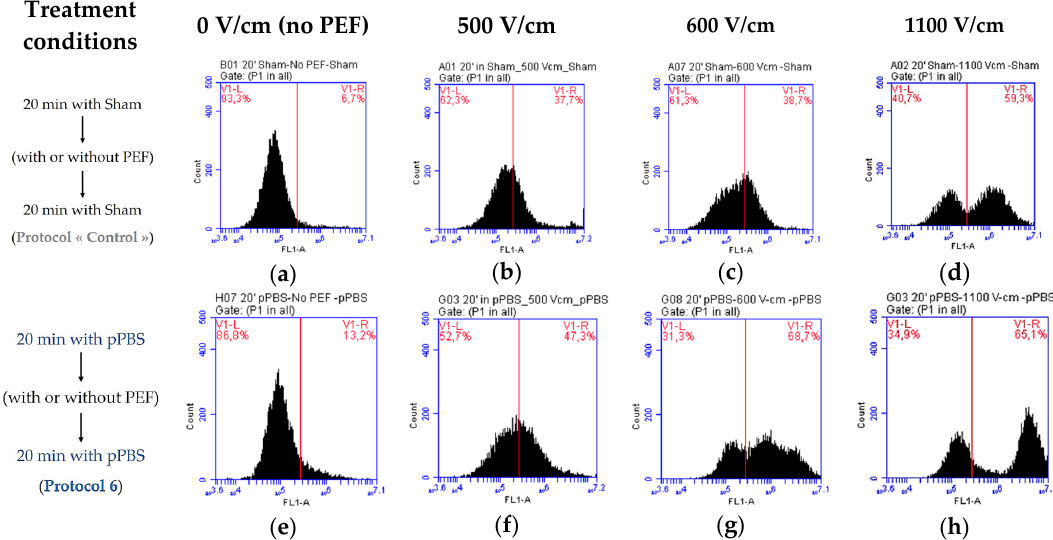
Figure 8. Flow cytometry analysis of a few interesting conditions of the combined treatment in adherent B16-F10 murine melanoma cells to compare effects of protocol 6 ( e – h ) versus the control ( a – d ) with µsPEFs of 0 ( a , e ), 500 ( b , f ), 600 ( c , g ), and 1100 ( d , h ) V/cm. The peak of count as a function of the green fluorescence (FL1-A) shifts towards higher values of the fluorescence per cell, indicating the enhancement of the permeabilisation of the cell membrane.